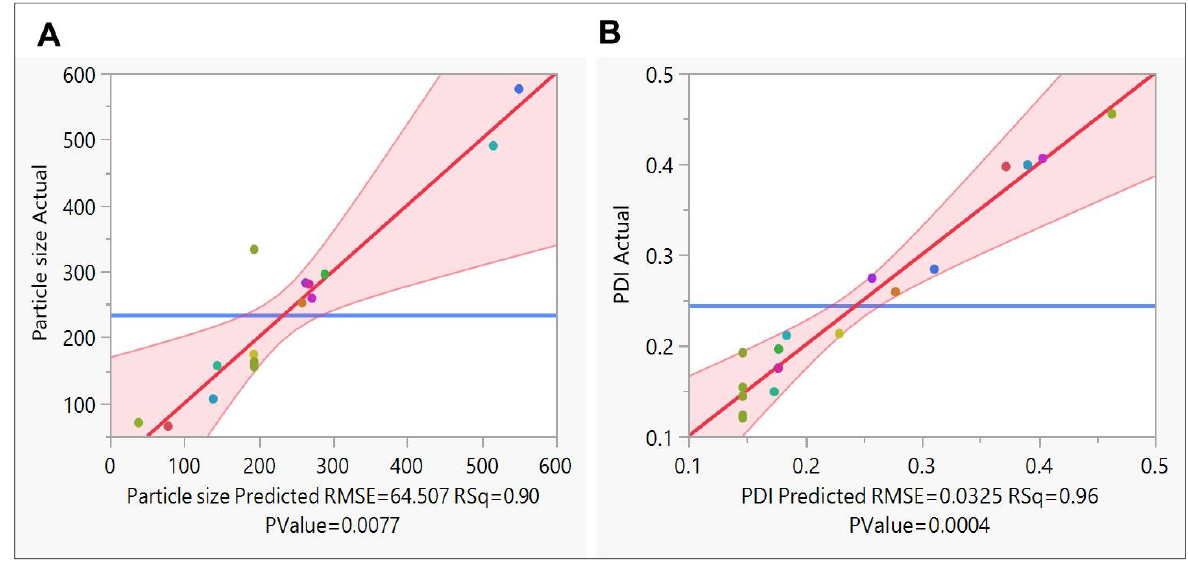
Figure 6. Statistical evaluation of prepared SLNs of ( A ) Predicted v/s actual plot for Particle size and ( B ) Predicted v/s actual plot for PDI.